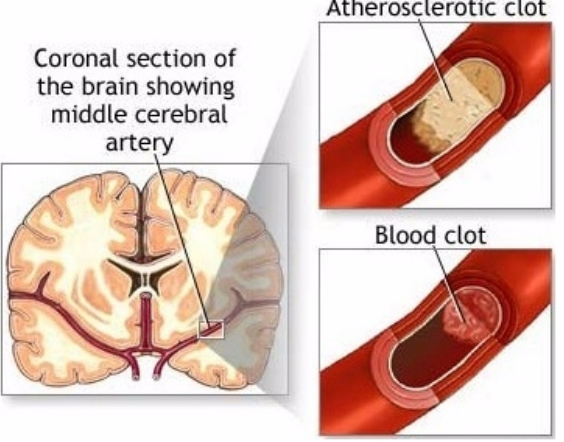
Figure 3. (left): schematic diagram of a coronal section of brain, the arterial composition of brain, pointing to the middle cerebral artery as it relates to basal ganglia. (right): upper and lower, schematic pictures of the endothelial lining of blood vessels forming a blood clot. Adapted from: